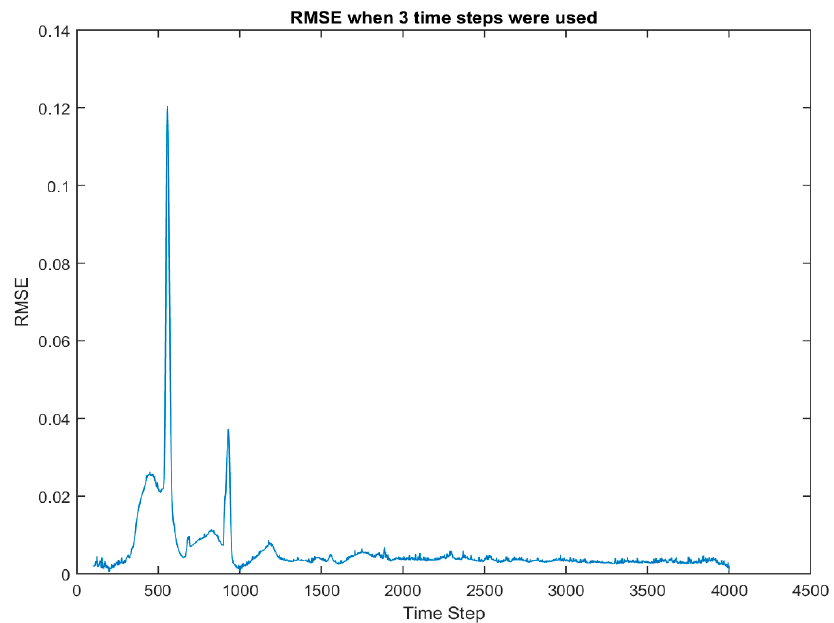
Figure 23. Root mean square error (RMSE) distribution over time, when three pairs of data are used for training. Fluids 2019 , 4 , x